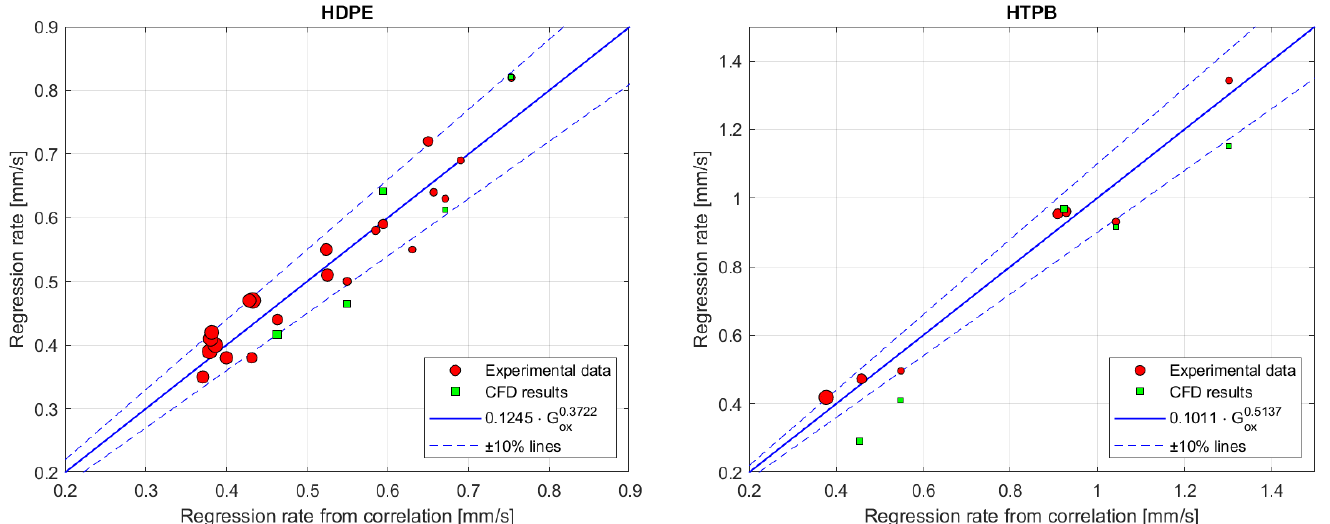
Figure 5. CFD results compared with experimental data for HDPE ( left , Table 1) and HTPB ( right , Table 2).